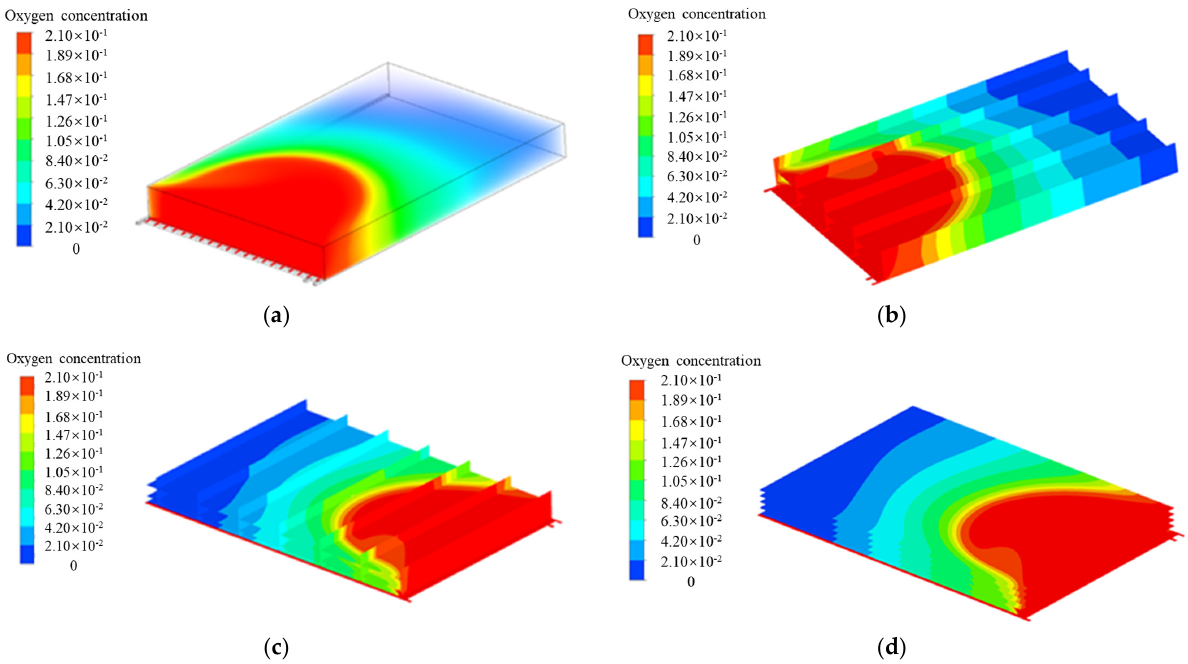
Figure 7. Oxygen concentration distribution in each axis (own elaboration). ( a ) Oxygen concentration distribution in gob. ( b ) Oxygen concentration distribution in yz ‐ plane. ( c ) Oxygen concentration distribution in xz ‐ plane. ( d ) Oxygen concentration distribution in z ‐ plane.